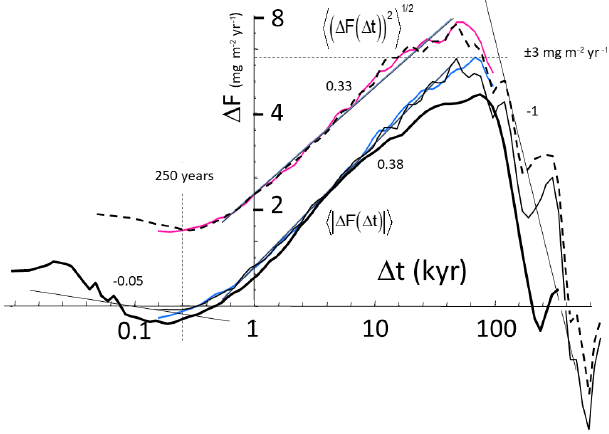
Figure 4. Log–log plot of the Fourier spectrum of the (25 year) − 1 resolution dust concentration in frequency units of kyr − 1 (red) and the same but of the logarithms of the flux (blue). Also shown is the average spectrum of the 5-year resolution data over the last 400kyr (green). For the latter, the periodograms of each the four most recent 100kyr cycles were averaged, but the full spectral res- olution (5 years) − 1 was retained. The beta parameters are the expo- nents of the theoretical spectrum (see main text, the negative of the logarithmic slope) for the macroclimate ( − 2 . 5), climate (1.7), and macroweather (0.8) regimes. The spectra were analysed using FFT (fast Fourier transform) with standard Hanning windows.